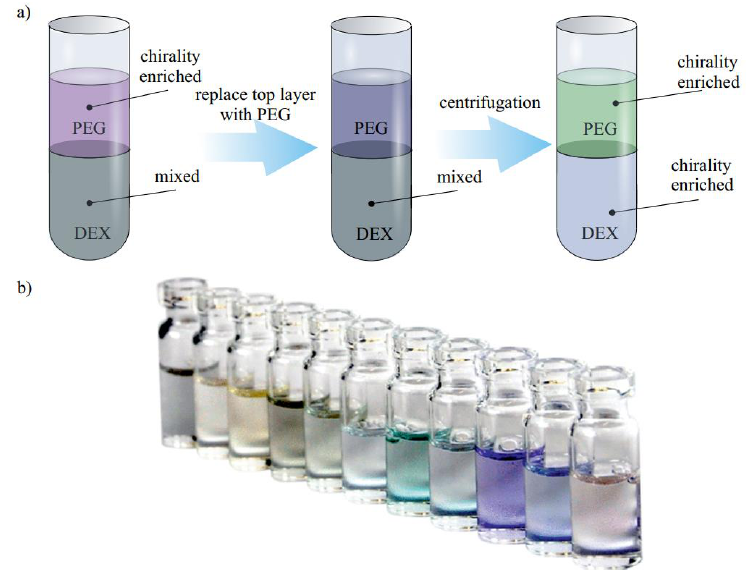
Figure 18. ( a ) Schematic illustration of two-phase separation for the multistep enrichment of single- chirality SWCNTs. ( b ) Optical photographs showing their distinct colors of 10 single-chirality SWCNTs achieved within three steps. When PEG and DEX solutions are mixed and two distinct aqueous phases form spontaneously, each has a different affinity towards SWCNTs. The phase en- riched with single-chirality SWCNTs then is replaced by fresh PEG or DEX until the full separation is achieved [128]. Copyright 2019, American Chemical Society.